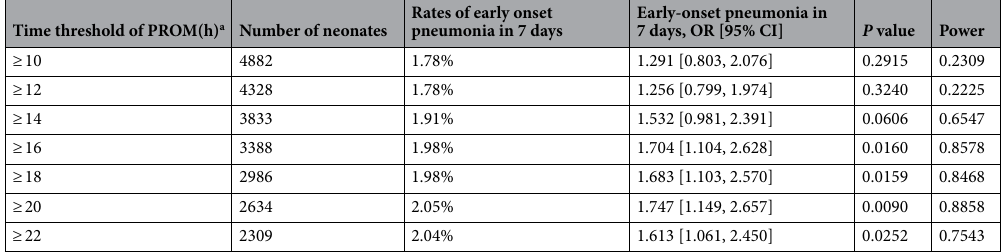
Rates of early onset pneumonia in 7 days